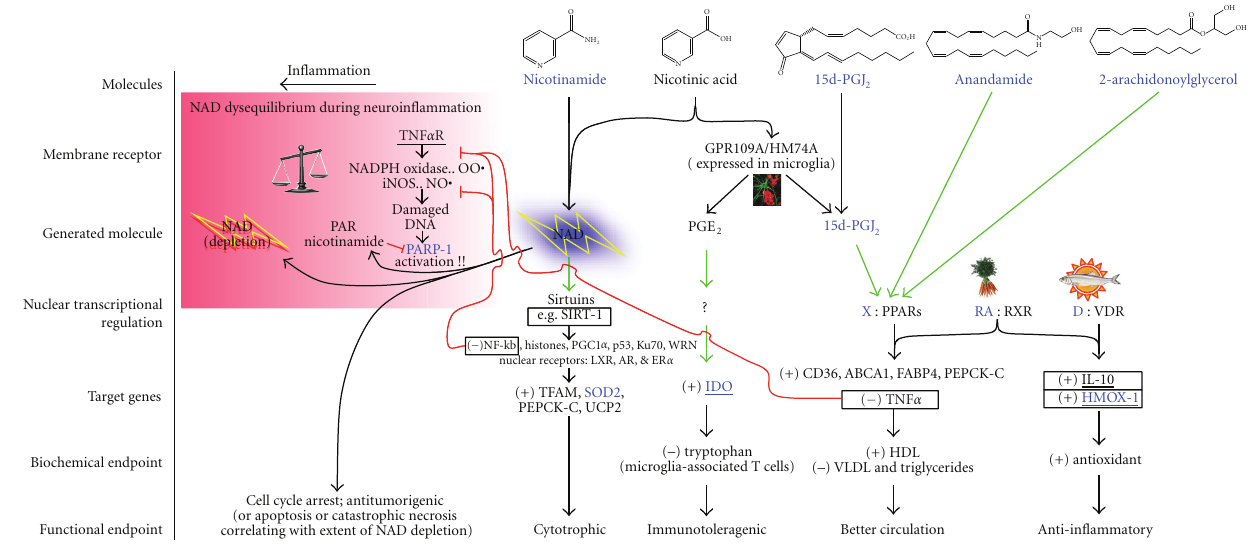
Figure 1: Unique mechanisms of action of nicotinic acid on immune function are shown. Nicotinic acid, but not nicotinamide, binds to the high-a ffi nity nicotinic acid G-protein-coupled receptor HM74a/GPR109a that via calcium influx activates phospholipase A 2 . This ultimately leads to massive production and release of prostaglandins 15d-PGD 2 and PGD 2 specifically from professional antigen presenting cells (macrophages, dendritic cells, and likely microglia [55]). Thus, nicotinamide, which also provides NAD, functions in part as a negative control for HM74a-dependent e ff ects in experimentation. PGE 2 was previously identified as promoting di ff erentiation of plasmacytoid dendritic cells to a T cell toleragenic phenotype via induction of IDO expression and activity [49, 50]. Consequently nicotinic acid may provide a similar T cell toleragenic e ff ect. 15d-PGD 2 spontaneously degrades to produce 15 Δ -PGJ 2 , the most potent endogenous activator of PPAR γ . This may be central to the explanation of how nicotinic acid but not nicotinamide corrects dyslipidemia, raising HDL levels higher than any known pharmaceutical including all PPAR γ agonists while also lowering LDL, VLDL, and triglycerides [30,